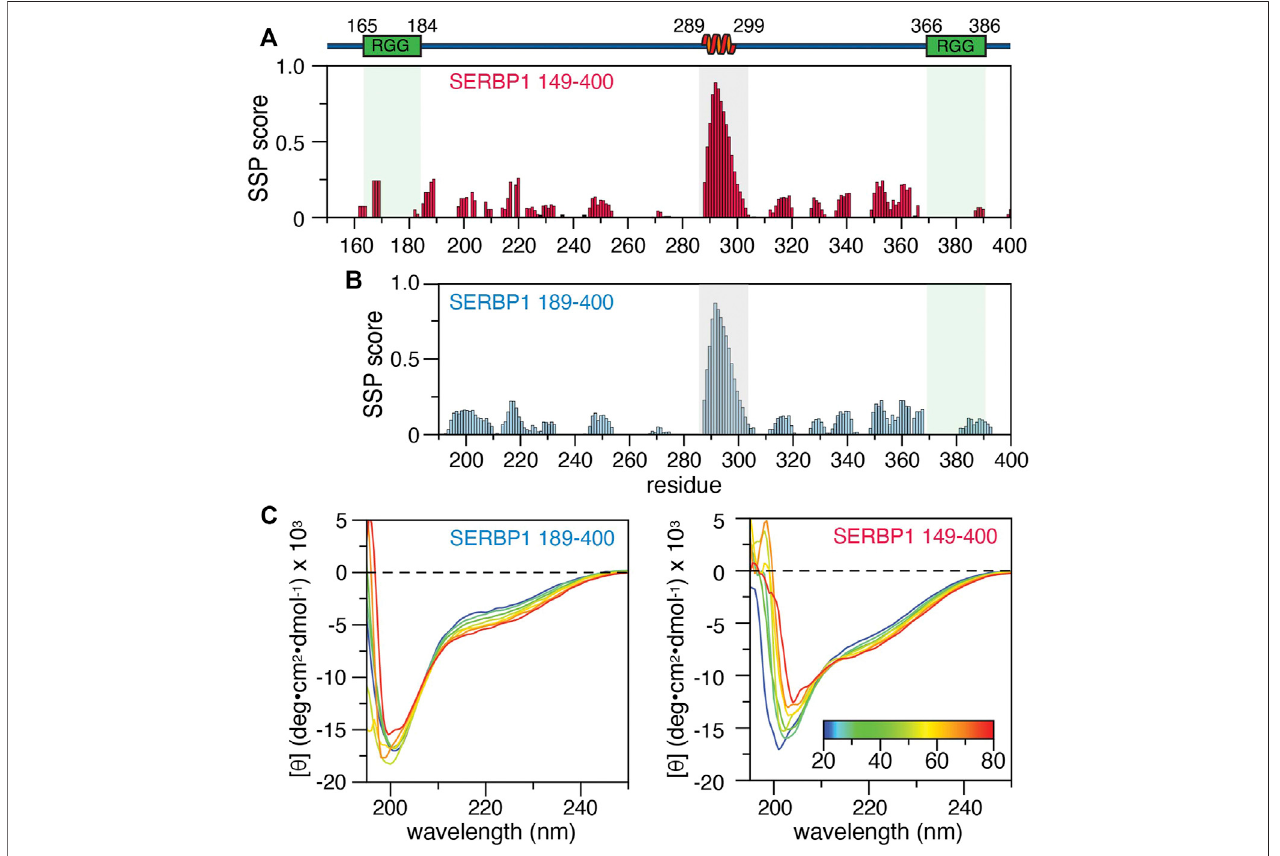
FIGURE 2 | Secondary structure of SERBP1 149 – 400 and 189 – 400. Secondary structure propensity calculated from backbone chemical shifts by the SSP algorithm for (A) SERBP1 149 – 400 and (B) 189 – 400. Gray boxes outline residues 289 – 299, identi fi ed as having a high α -helical character. A cartoon representation of the α -helixandrelativepositionoftheRGGboxes(green)isshownabovetheplots. (C) CDspectraofSERBP1189 – 400 (right) andSERBP1149 – 400 (left) acquiredat 10 ° C intervals from 20 ° C to 80 ° C.